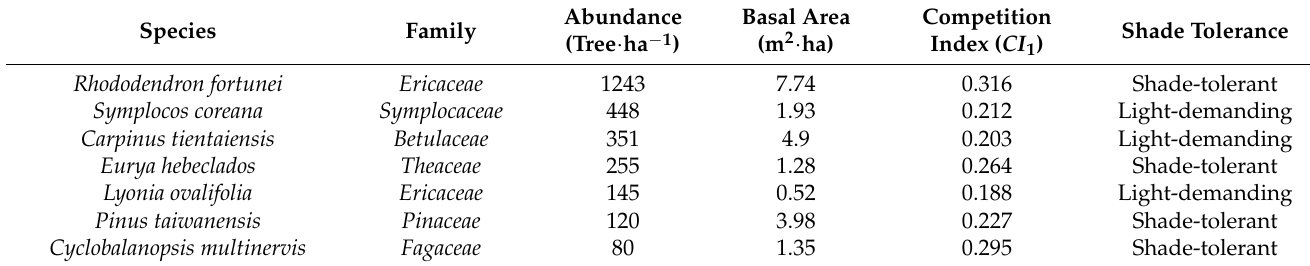
Table 1. Abundance, basal area (BA), and competition index shade tolerance of the common species in the Carpinus tientaiensis sampling plot. Shade tolerance categories for each species were obtained from Lu and Yan